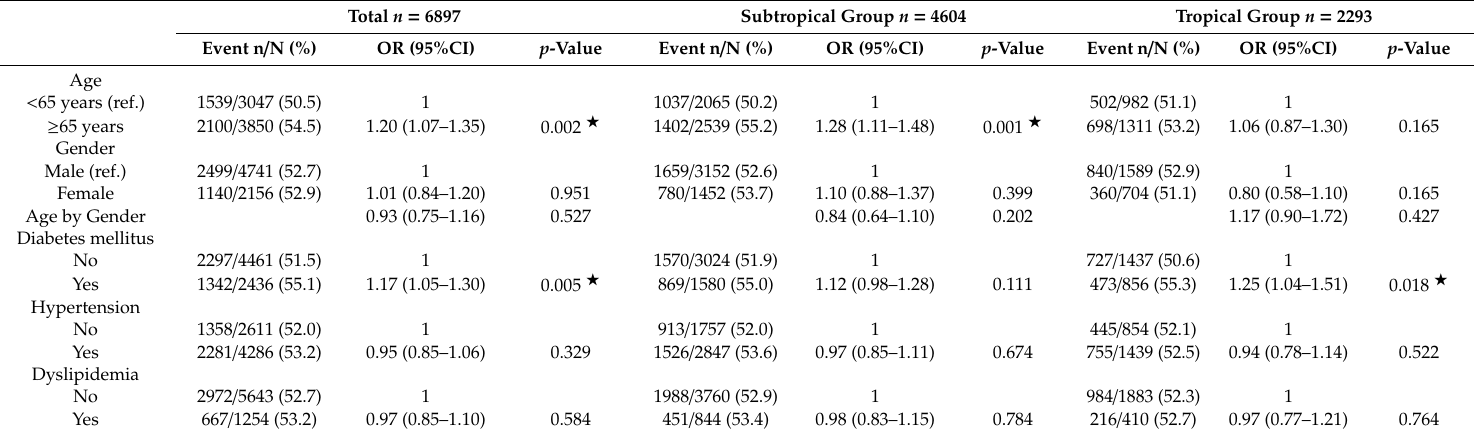
Table 4. Logistic regression model on the association of the cold season with AMI hospitalization.